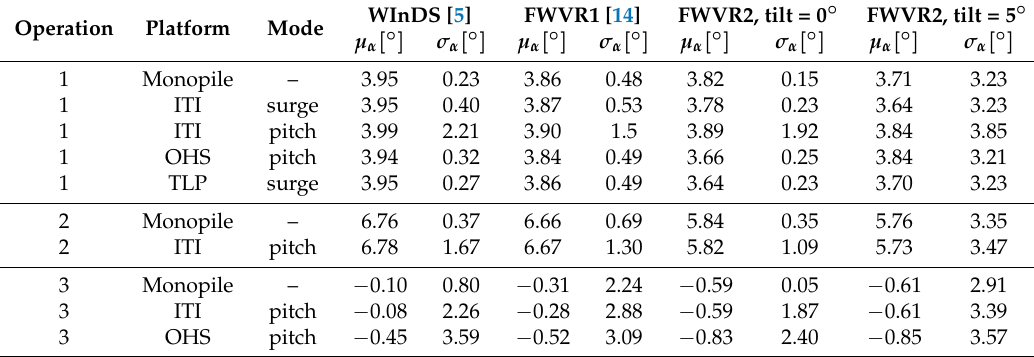
Table 4. Mean and standard deviation of α at the outboard 2/3 part of the blade.